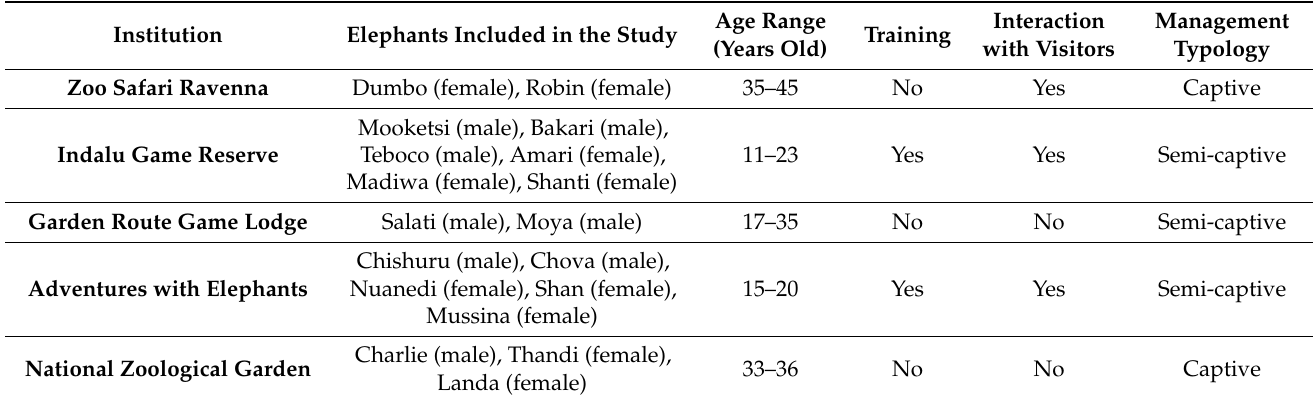
Table 1. Summary of each study location, including the elephants’ name, their age at the study time, the presence or absence of a training program, whether the animals were involved in interactions with visitors, and whether held in the captive or semi-captive management